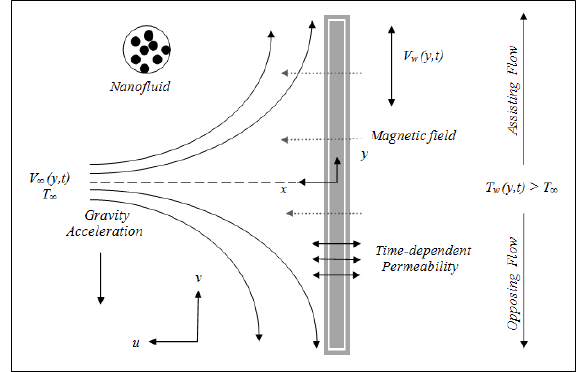
Fig. 1: Coordinate system of flow